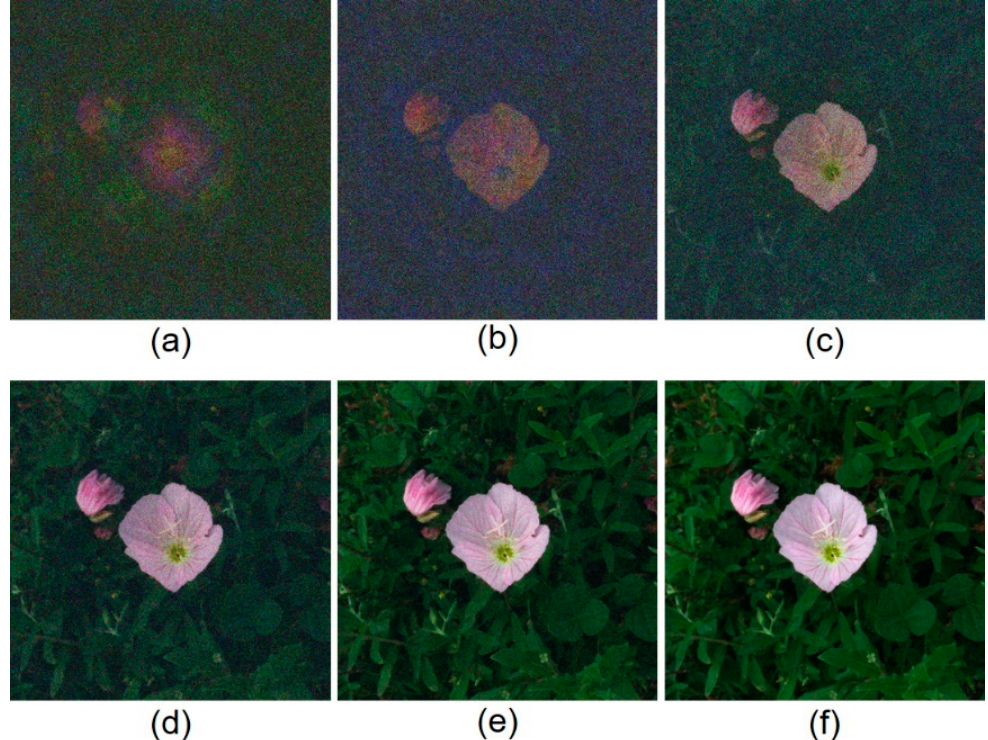
Figure 8. Numerical results presented in Section 3.2 under the assumption that λ 2 is 561 nm instead of 532 nm. Reconstructed images when bit depths of holograms are ( a ) 2, ( b ) 3, ( c ) 4, ( d ) 5, ( e ) 6, and ( f ) 7 bits.